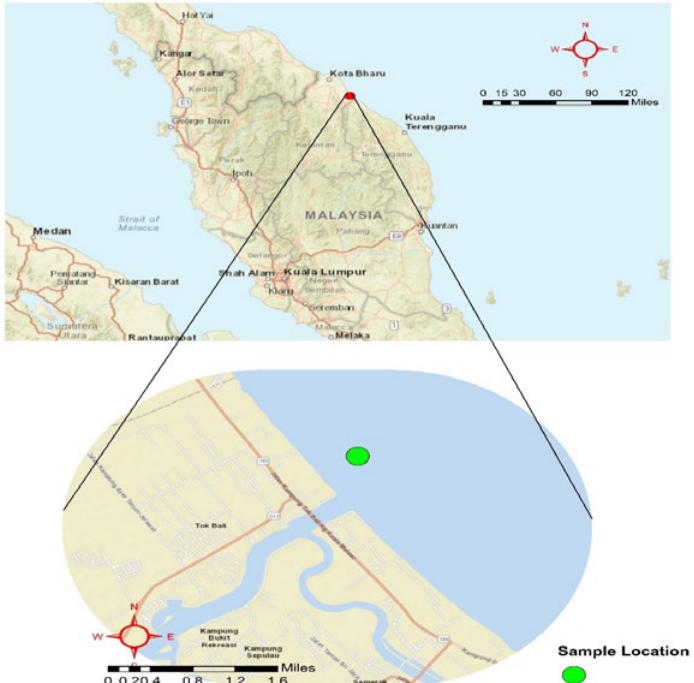
Fig. 1. Geographic location of the study area along with the sampling sites in Kelantan, Malaysia